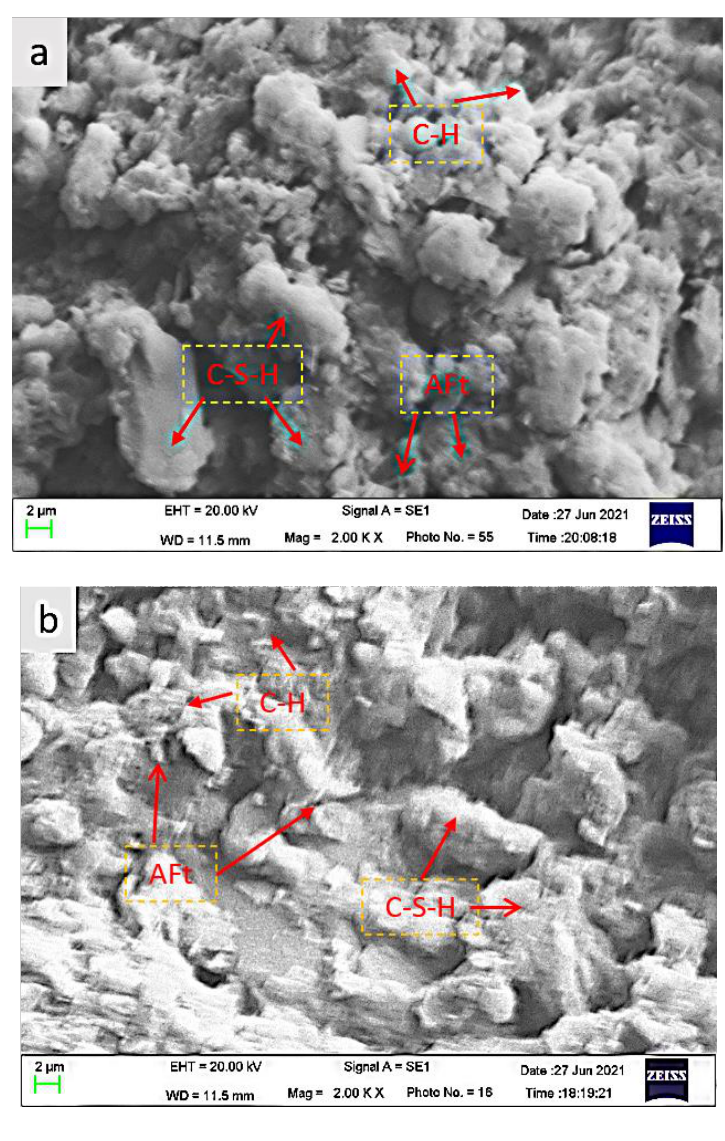
Figure 13. SEM of CFTCB with different curing times: ( a ) 3 d; ( b ) 7 d.